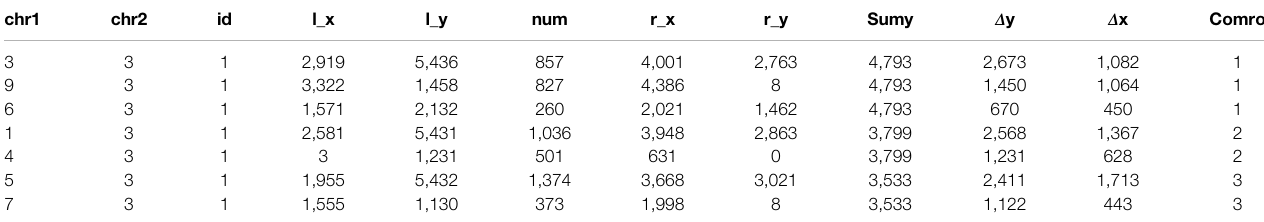
TABLE 4 | Arabidopsis thaliana Chr. 3 result.csv fi